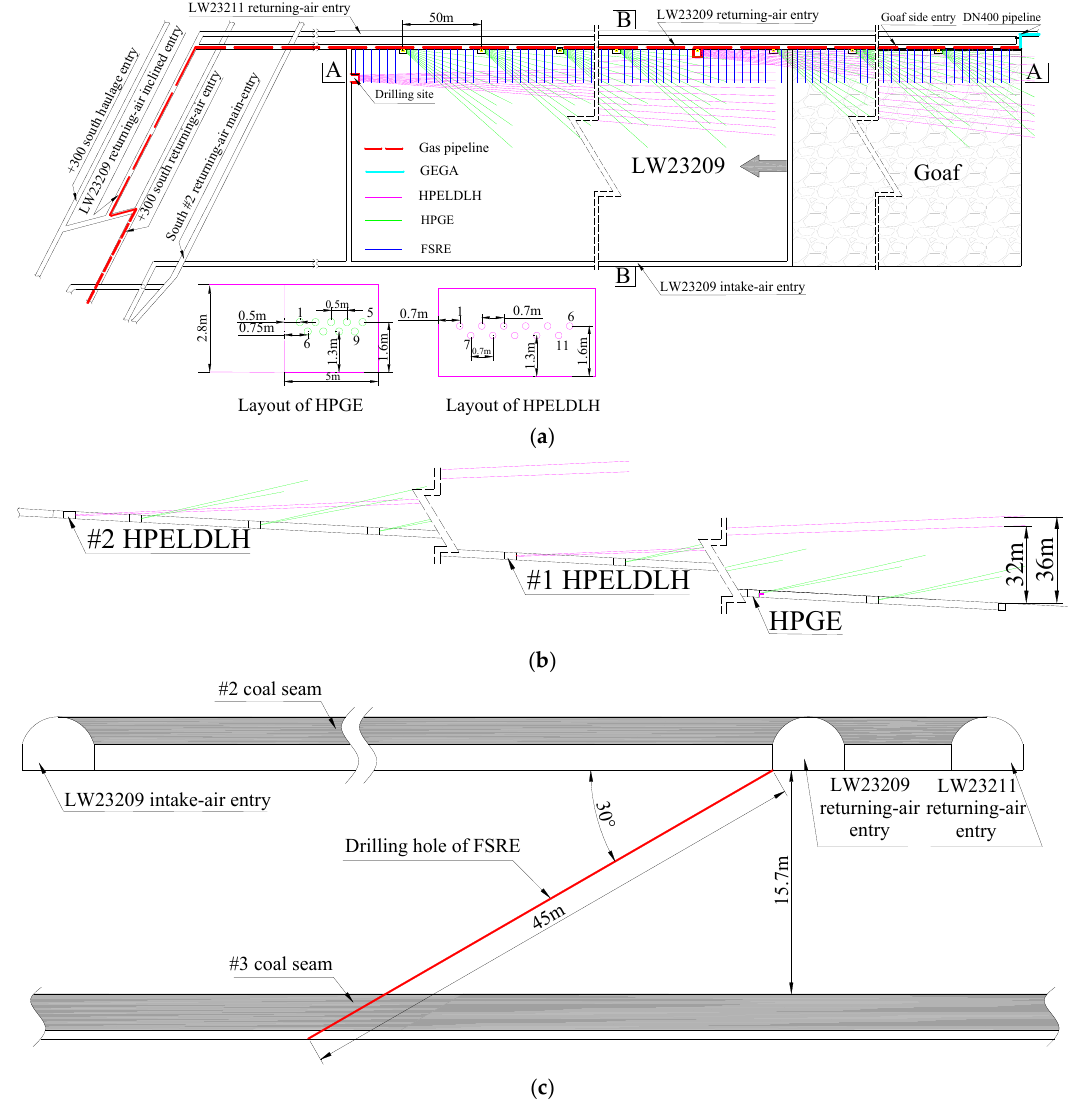
Figure 11. Gas drainage pipelines and borehole layout: ( a ) Pipelines and borehole layout; ( b ) Section A-A; ( c ) Section B-B.